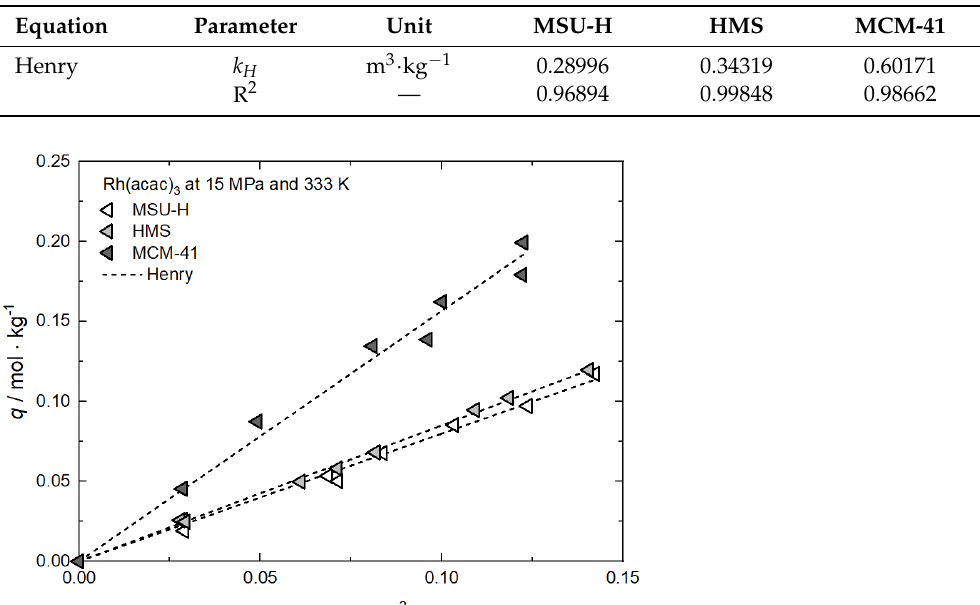
Figure A11. Uptake of Rh(acac) 3 at 15 MPa and 333 K on different substrates; experimental data taken from [62]. Table A11. Adsorption isotherm parameters for Rh(acac) 3 from scCO 2 solution at 15 MPa and 333 K on different substrates [62].